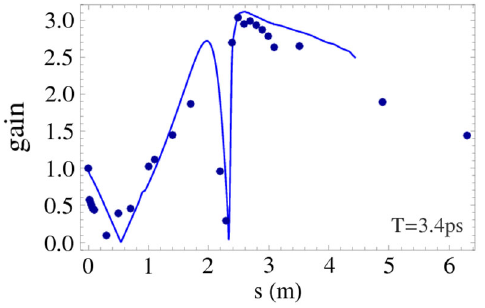
FIG. 7. Initial sinusoidal perturbation gain evolution inside the injector from the IMPACT simulations (dots) and the linear model